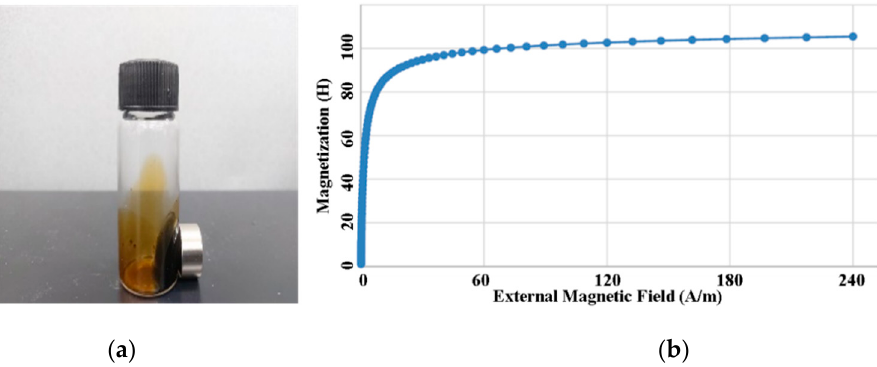
Figure 6. ( a ) The magnetic nanoparticle (MNP) material property (ferrofluid, EMG 707) used for